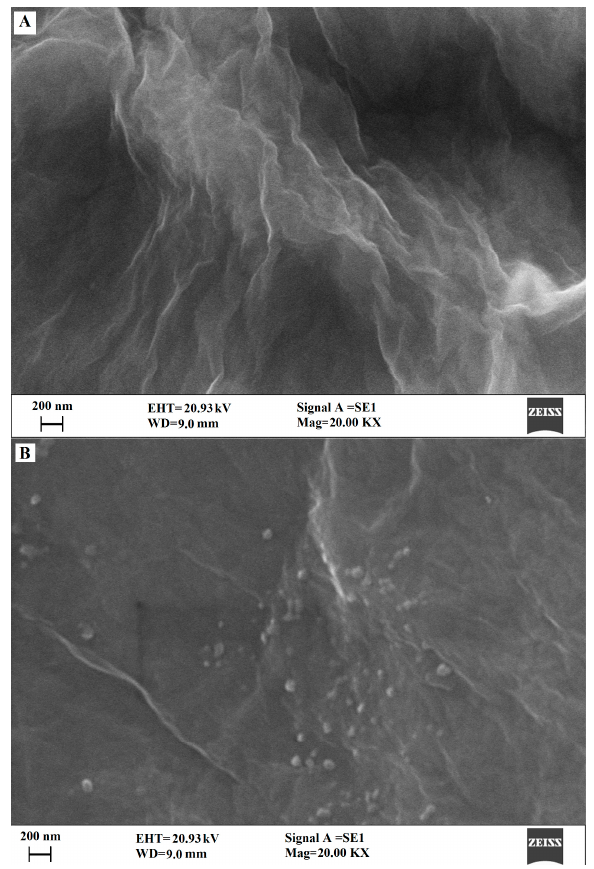
Figure 1. Scanning electron microscopy (SEM) images of ( A ) GO and ( B ) cuprous oxide functionalized electroreduced graphene oxide (Cu 2 O-ERGO) nanocomposite.